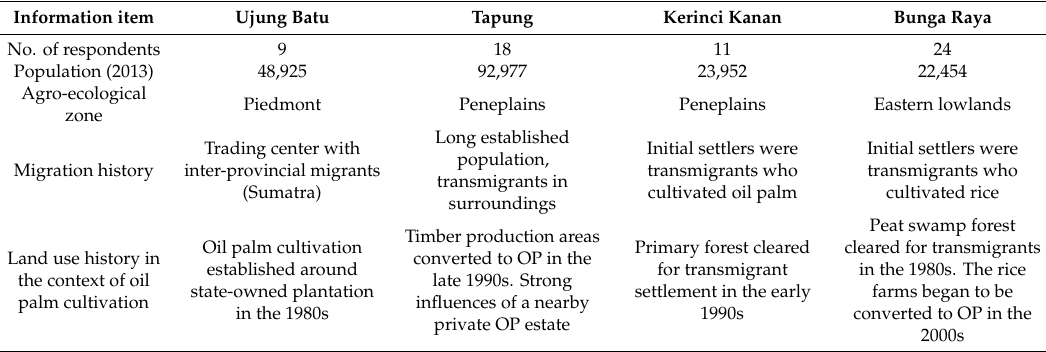
Table 1. Basic information, landscape characteristics, and migration and land-use histories of four villages